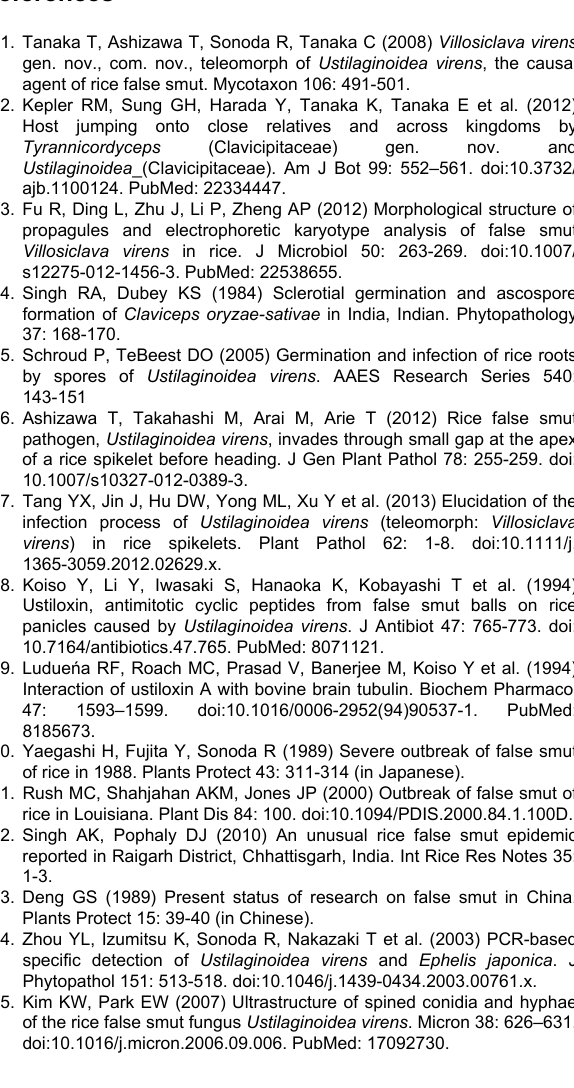
Table S1. Geographical distributions and haplotypes of U. virens isolates. (XLS) Table S2. Sequence differences among 56 haplotypes found at the three loci with enriched SNP sites. (XLS) Figure S1. Allelic combination showing evidence of